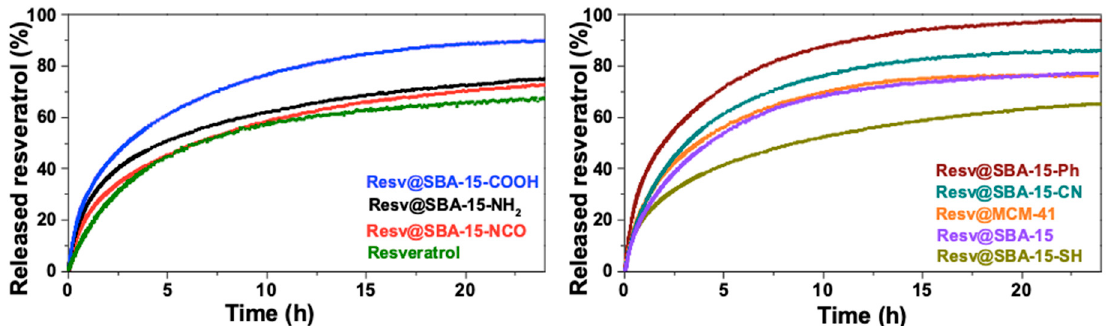
Figure 1. Resveratrol release from functionalized SBA-15 carriers in comparison with pristine silica with different pore